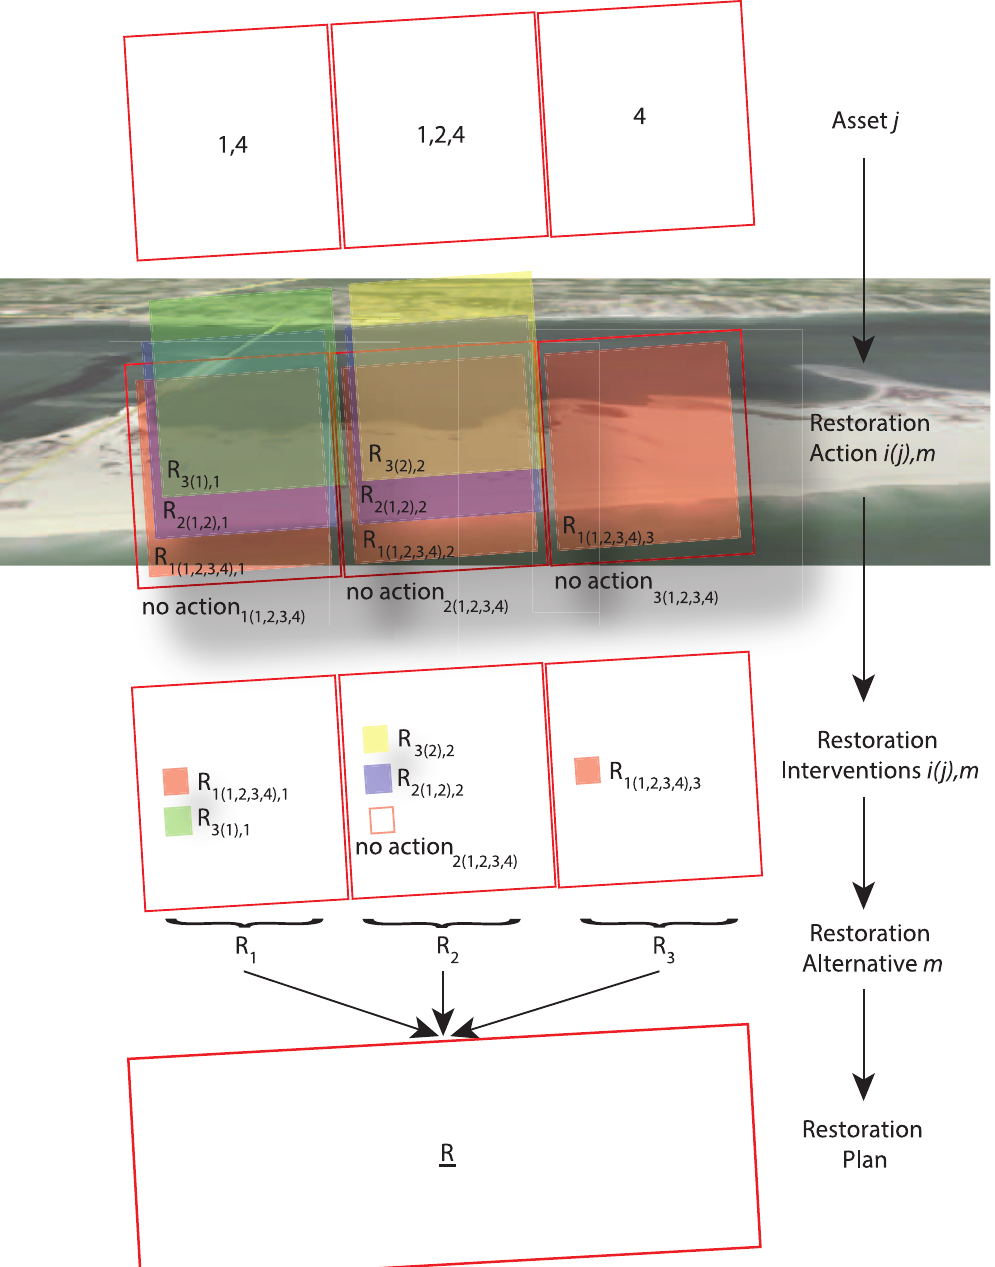
Figure 2. Management scales and actions. An example is reported for three management areas in SRI. Assets in each management area are indicated by the number contained in each area (e.g., 1 is the SP, 2 is the PP and 4 is the military area). Thus, management area one has two types of assets, management area two has three types of assets, and management area three has one type of assets. At least one action for each asset is evaluated in each management area. The restoration actions are indicated as R i(j),m (where, i is the action, j is the asset, and m is the management area). Same actions can be evaluated for different assets (e.g. nourishment) because different assets can benefit from the same actions. Only one action is selected by the PDM or by the MCDA model. The selected actions are called restoration interventions. The whole set of restoration interventions in a management area is called restoration alternative, and the set of restoration alternatives is defined as restoration plan.